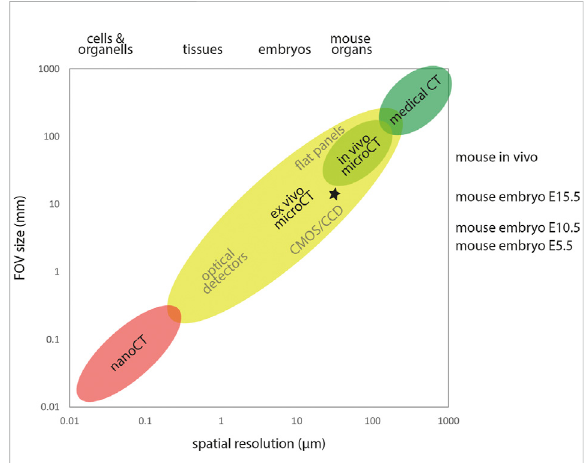
FIGURE 1 X-ray computed tomography across scales. X-ray computed tomography covers a wide range of samples sizes and spatial resolution. Detector size and FOV typically constrain the achievable spatial resolution. MicroCT encompasses FOVs from roughly 0.3 – 300 mm, delivering spatial resolution in the micron range. In the high throughput IMPC screening (Dickinson et al., 2016), E15.5 embryos were imaged using a lateral FOV of ~13 mm and an isotropic voxel size of ~13 µm, yielding a spatial resolution of ~30 µm in reconstructed image volumes